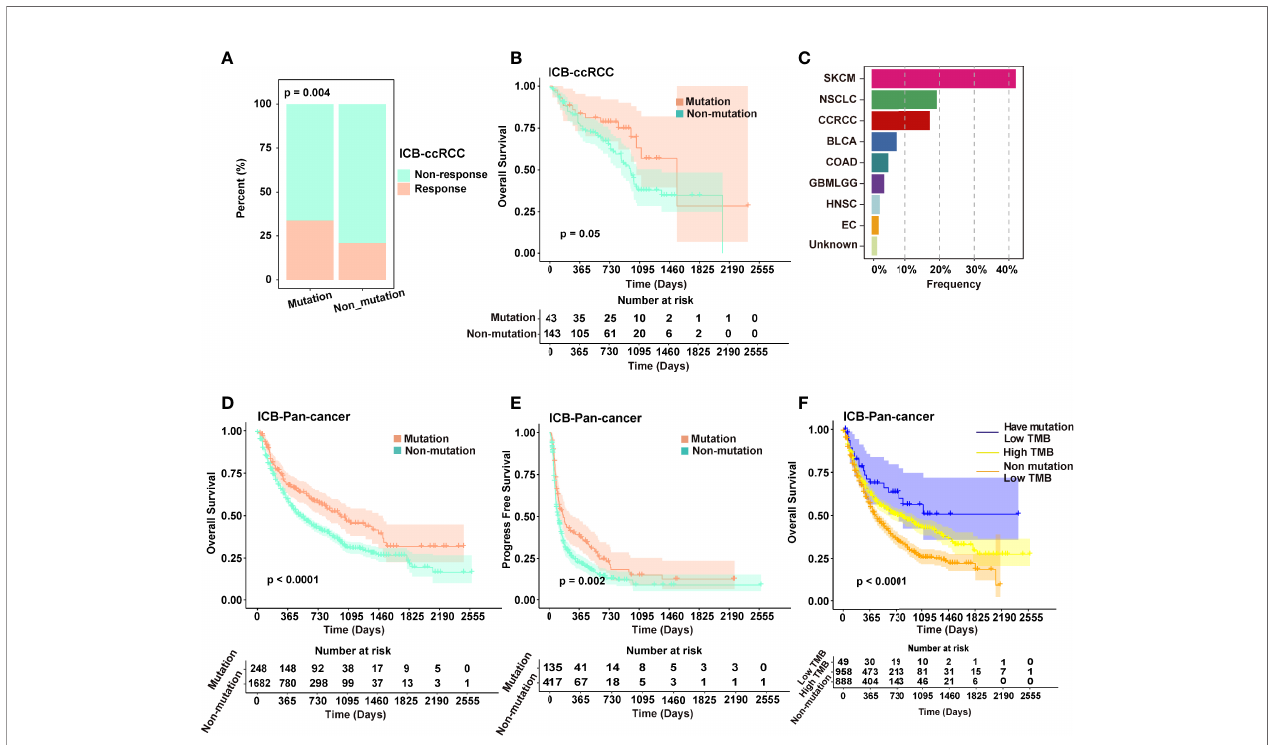
FIGURE 5 | (A) Different distribution ratio of response and non-response in the immunotherapeutic cohort of ccRCC. (B) Kaplan – Meier analysis of patients in the mutated and non-mutated groups in the immunotherapeutic cohort of ccRCC (Van_2018, Morris_2019, PMID29337640 and PMID29301960). (C) The composition of major cancer types in the immunotherapeutic cohort contains mutations of pan-cancer. (D, E) Kaplan – Meier analysis (OS and PFS) of patients in the mutation and non-mutation groups in the immunotherapeutic cohort of pan-cancer. (F) Kaplan – Meier analysis of patients in the low TMB of mutated, low TMB of non-mutated, and high TMB